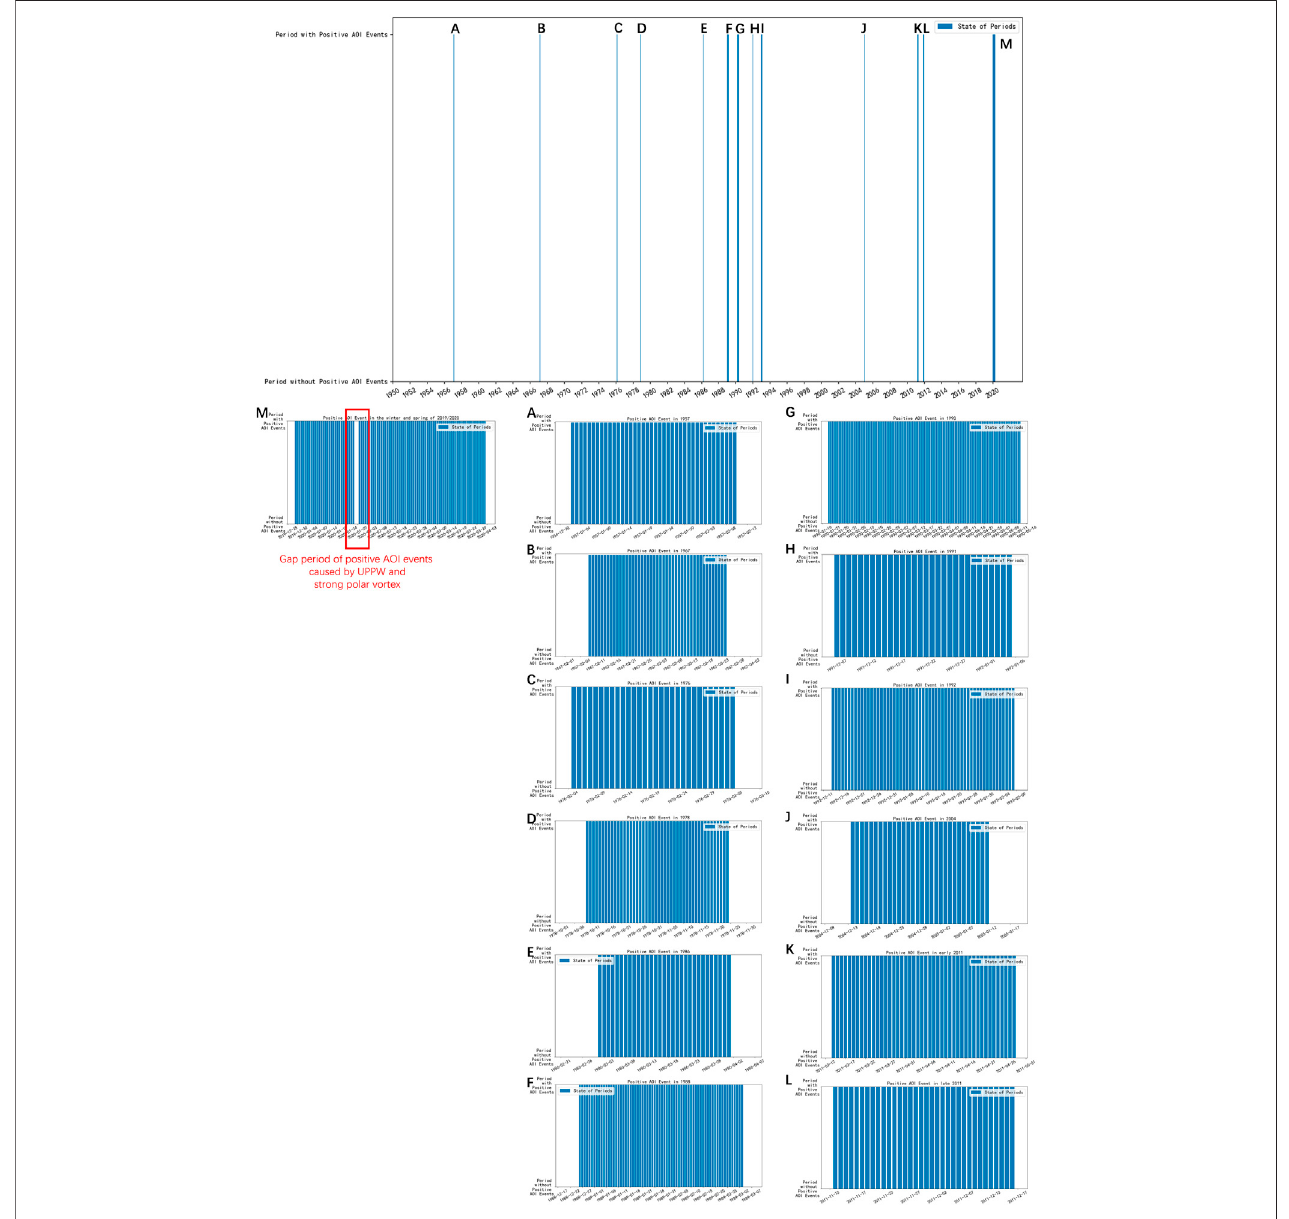
FIGURE9| PositiveAOIeventdays(calculatedaccordingtothestandardinSection DevelopmentofPositiveArcticOscillationIndexEvents )in (A) 1957, (B) 1967, (C) 1976, (D) 1978, (E) 1986, (F) 1988, (G) 1990, (H) 1991, (I) 1992, (J) 2004, (K) early 2011, (l) late 2011, and (M) the winter and spring of 2019/2020.